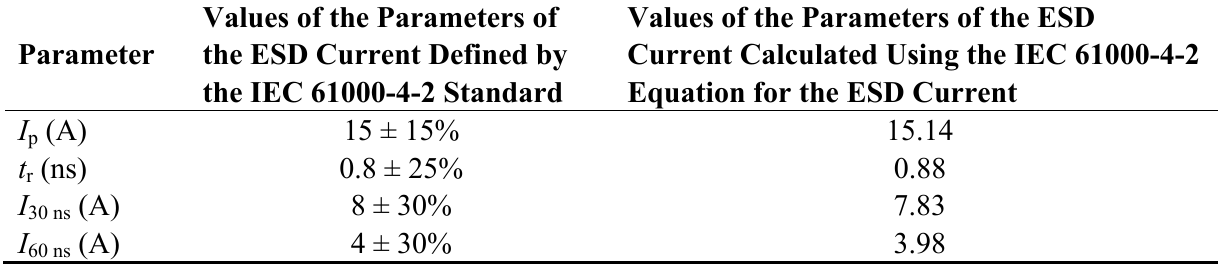
Table 1. Parameter values of IEC 61000-4-2 equation for the ESD current. Discharge voltage +4